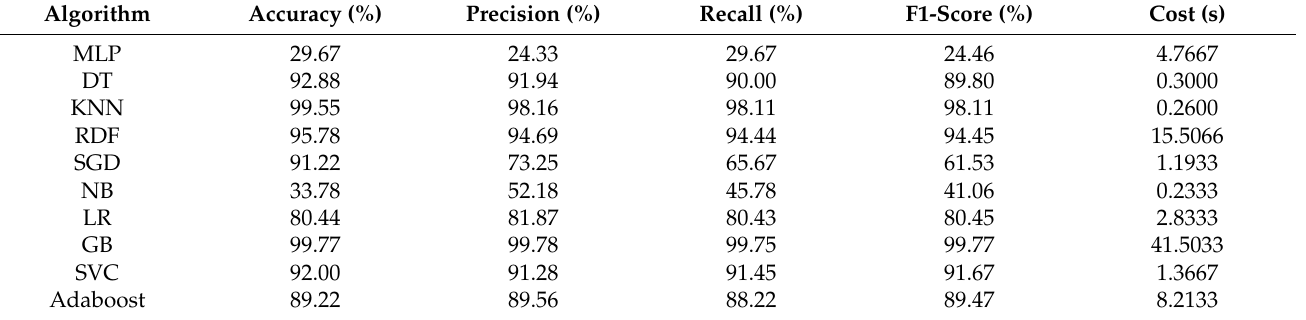
Table 15. Global performance comparison of ML models using combination of (RS) and (D) features.